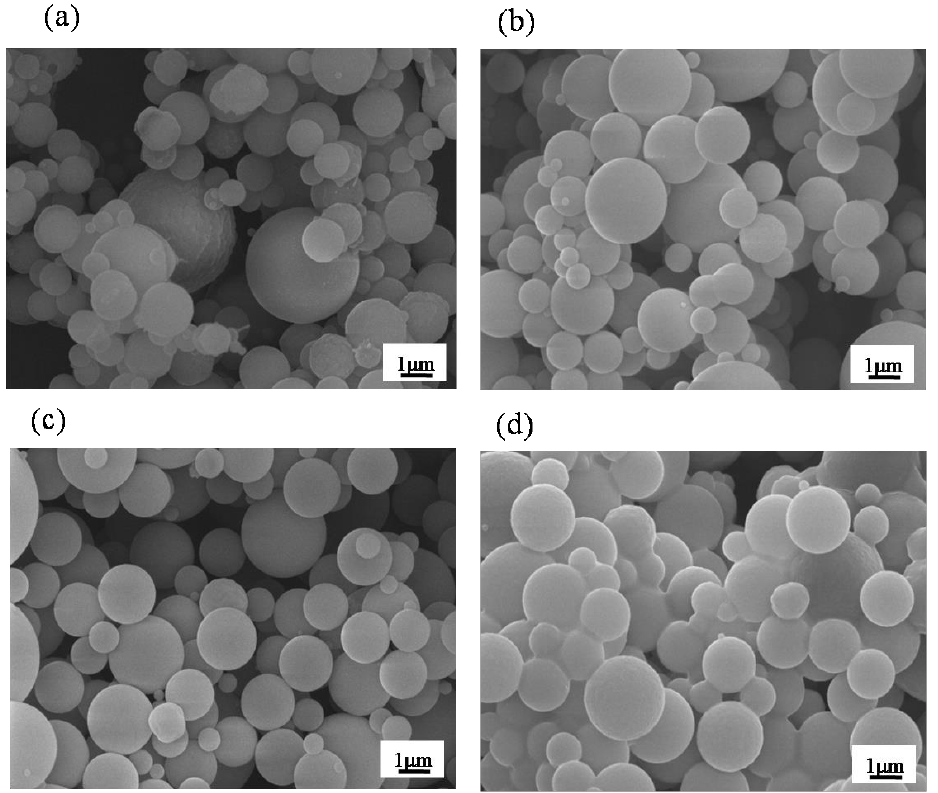
Figure 2. SEM images of ( a ) un-treated BG particles and ( b ) 0.1 M, ( c ) 0.3 M, and ( d ) 0.5 M PEG-treated BG particles. BG